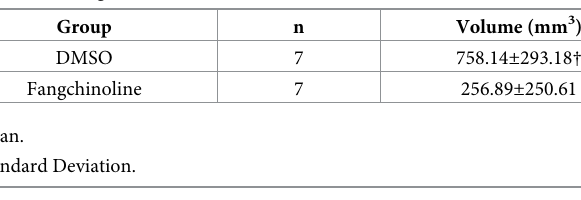
Table 1. Tumor growth in nude